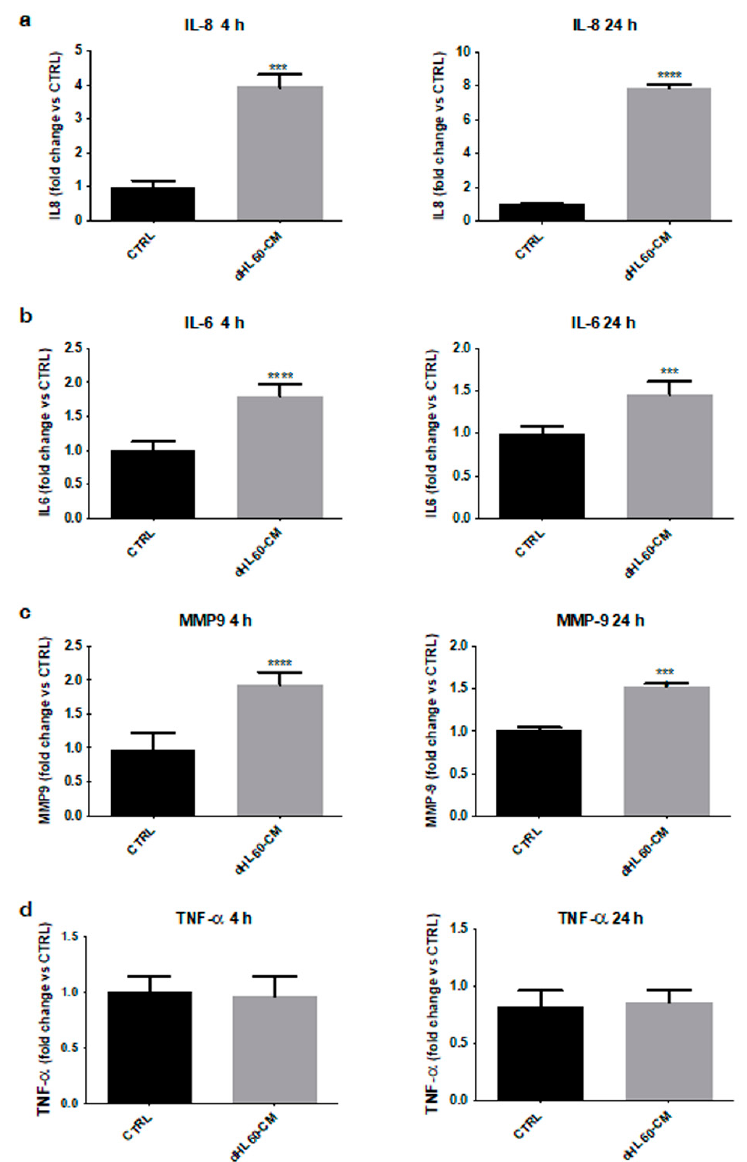
Figure 5. Melanoma SC-activated neutrophils secrete increased levels of tumor-promoting factors. ( a ) dHL60 cells were incubated with CSC-CM for 4 and 24 h, then their supernatant was changed with proper medium for 24 h. IL-8 secretion was then assessed by Elisa assay. Each experiment was repeated three times. Data are expressed as mean values ± SEM and were analyzed by t -test. *** p < 0.001 vs. ctrl (control), **** p < 0.0001 vs. ctrl (control). ( b ) dHL60 cells were incubated with CSC–CM for 4 and 24 h, then their supernatant was changed with proper medium for 24 h. IL-6 secretion was then assessed by Elisa assay. Each experiment was repeated three times. Data are expressed as mean values ± SEM and were analyzed by t -test. *** p < 0.001 vs. ctrl (control), **** p < 0.0001 vs. ctrl (control). ( c ) dHL60 cells were incubated with CSC–CM for 4 and 24 h, then their supernatant was changed with proper medium for 24 h. MMP-9 secretion was then assessed by Elisa assay. Each experiment was repeated three times. Data are expressed as mean values ± SEM and were analyzed by t -test. *** p < 0.001 vs. ctrl (control), **** p < 0.0001 vs. ctrl (control). ( d ) dHL60 cells were incubated with CSC–CM for 4 and 24 h, then their supernatant was changed with proper medium for 24 h. TNF- α secretion was then assessed by Elisa assay. Each experiment was repeated three times. Data are expressed as mean values ± SEM and were analyzed by t -test.